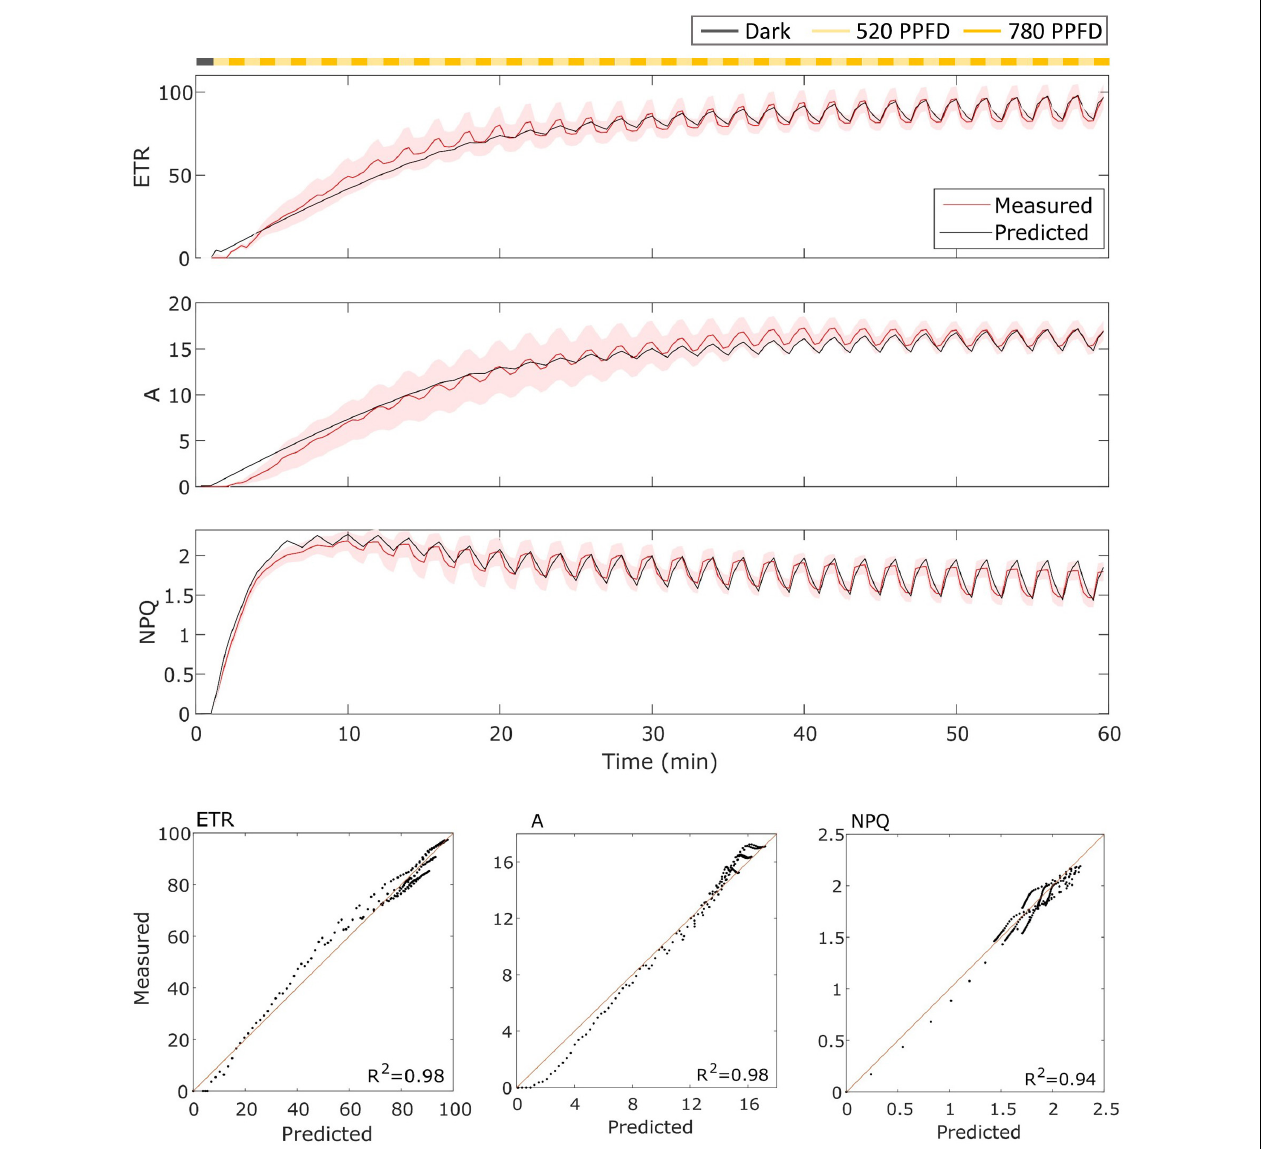
FIGURE 3 | (Top) Eiko data (indicated in red) compared to model results (indicated in black) in the fluctuating light regime. The data are shown as means of three replicates (indicated as a red continuous line) and their standard error (indicated as the red shaded area around the mean value). (Bottom) Parity plots for ETR, A , and NPQ with related R 2